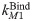
Mathematical model with different scales based on [14, 16].Production of virus particles in mammalian cells can be investigated in T-flask experiments (A). The extracellular model is represented by the dashed box (B). Uninfected target cells can be infected by virus particles. Both infected and uninfected cells can become apoptotic. The intracellular model describes the replication of the viral genome (C). The mathematical description of the intracellular model starts with the virus in the endosome. Different intracellular stages can be influenced by several HCFs. After transcription and translation of the viral genome new virus particles can be released to the surrounding medium. The rates affected by genetic modification (arrows in C) are marked with the yellow asterisks. As an example, the distribution of the matrix protein M1 (PM1) and the parameter kM1Bind (red arrow in C) are shown for two different time points (D).